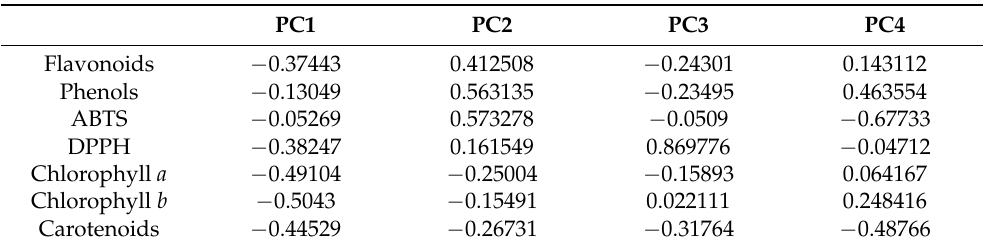
Table 2. Rotated principal component matrix and individual proportion of variance for each measured metric. PC1 PC2